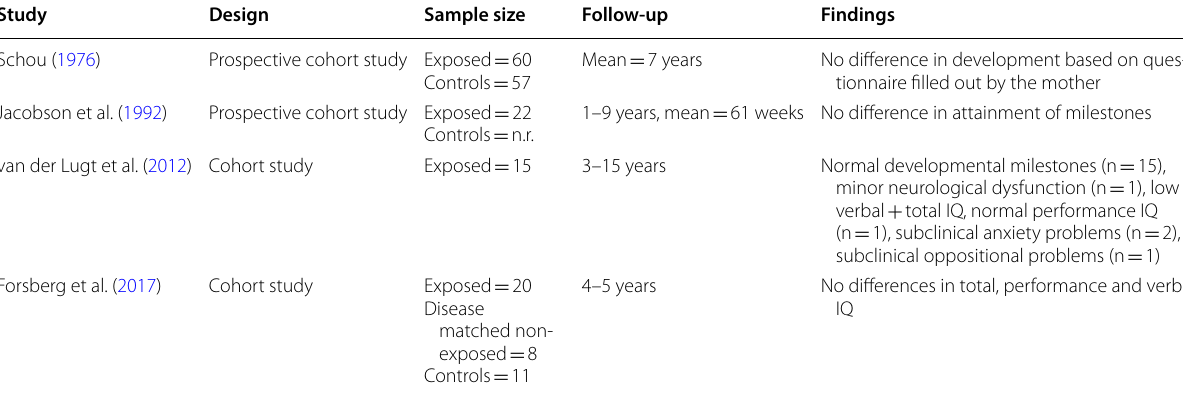
IQ intelligence quotient, n.r. not